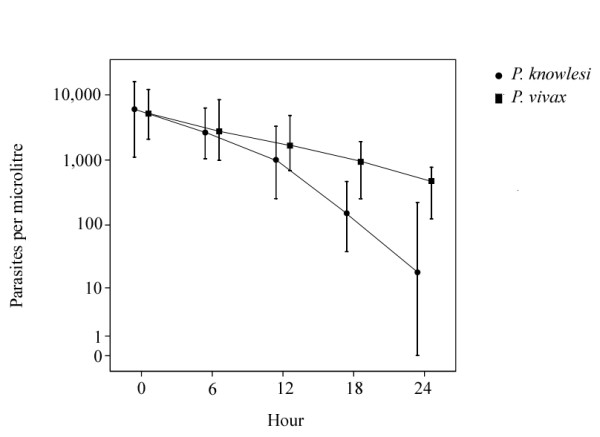
Parasite clearance during the first 24 hours of treatment with oral chloroquine. Graph shows median and 25%-75% interquartile ranges.